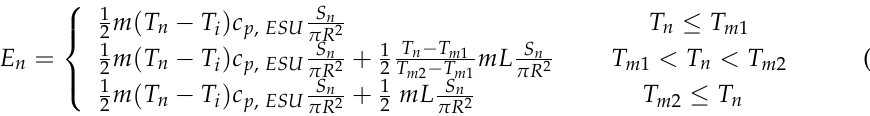
Figure 12. Volume-averaged temperature versus charging time for PCM panels with: PY—pyramids, PYO—pyramids with offset, PYR—pyramids with rotation, CY—cylinders, CYO—cylinders with offset (adapted, copyright 2022 Kamidollayev et al. (http://creativecommons.org/licenses/by/4.0/), accessed on 26 September 2022) [35].